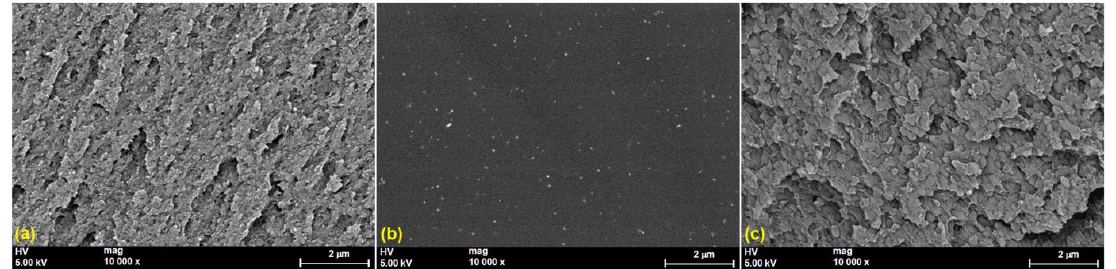
Figure 10. SEM images of the studied samples after incorporating Ag nanoparticles: HPMC-AgNPs ( a ), PVP-AgNPs ( b ) and HPMC/PVP-AgNPs ( c ) recorded with a magnification of 10,000×.